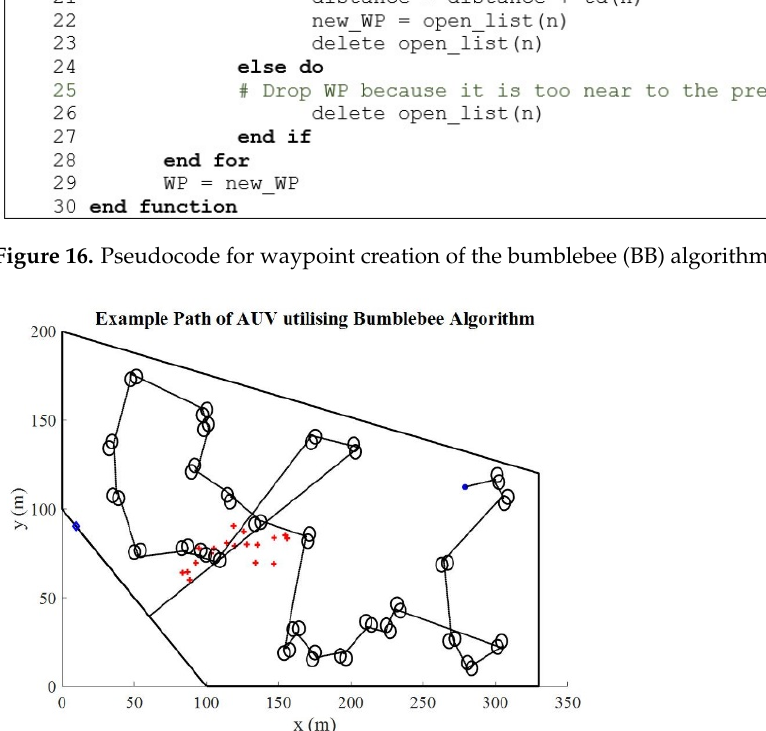
Figure 16. Pseudocode for waypoint creation of the bumblebee (BB) algorithm.